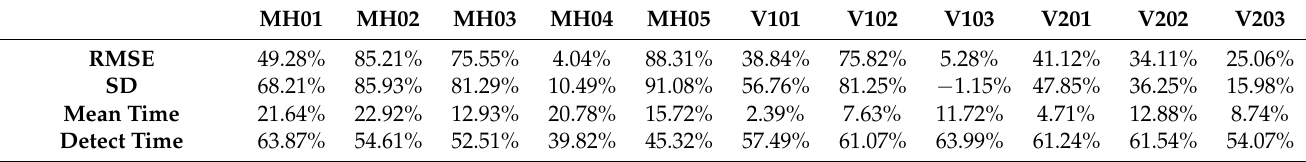
Table 3. Improvement of RMSE, SD, mean tracking time and loop closure detection